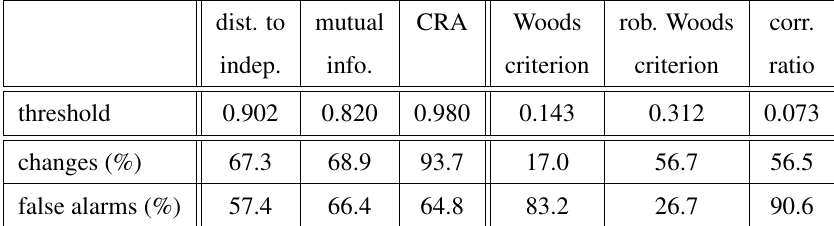
Table 3. Panchromatic/SAR pair: change and false alarm estimates based on mean similarity measure thresholds. dist. to mutual CRA Woods corr. indep. info. criterion criterion ratio